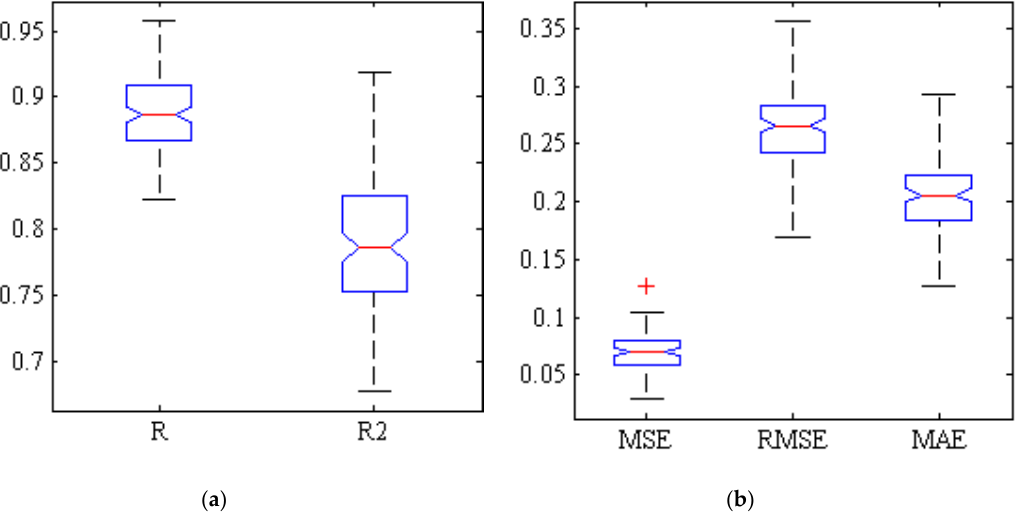
Figure 6. Box diagram of five criteria for evaluation of ANN-BBO performance in estimating TSS of Fuji